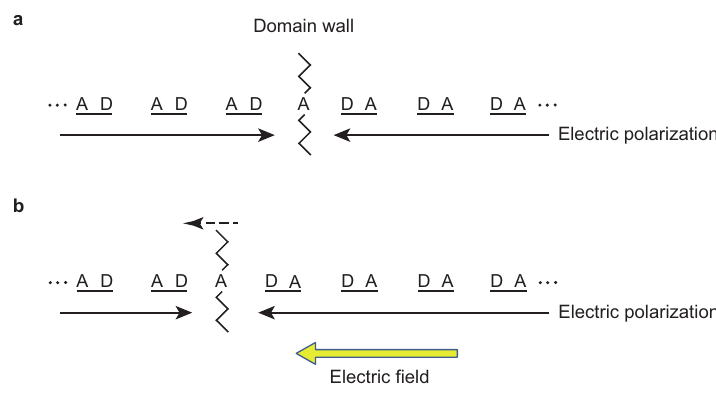
Figure 3. ( a ) Structure in the case of a head-to-head domain wall. ( b ) Shift of the domain wall under an applied electric field. TTF and 2,5-QBr 2 I 2 are denoted by D (donor) and A (acceptor), respectively, and the underlines represent the dimerization of the two molecules. For simplicity, the domain wall is depicted as an atomically thin boundary, but in reality, it likely has a finite width, particularly when the system is located near the ferroelectric quantum critical point